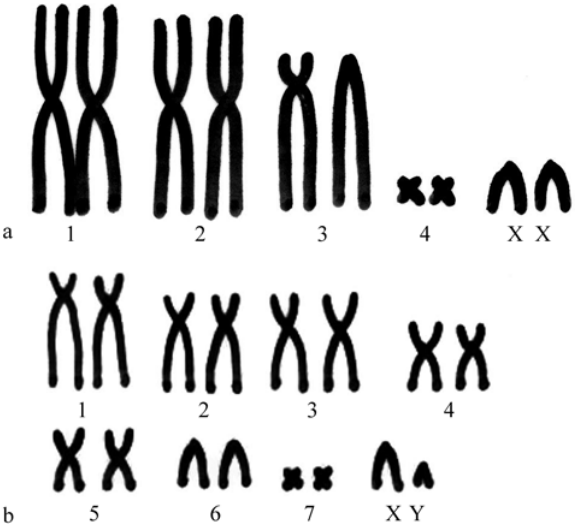
Figure 1 - Diagrammatic representation of Akodon karyotypes: (a) 2n = 10 with pair 3 heteromorphic. (b) 2n =